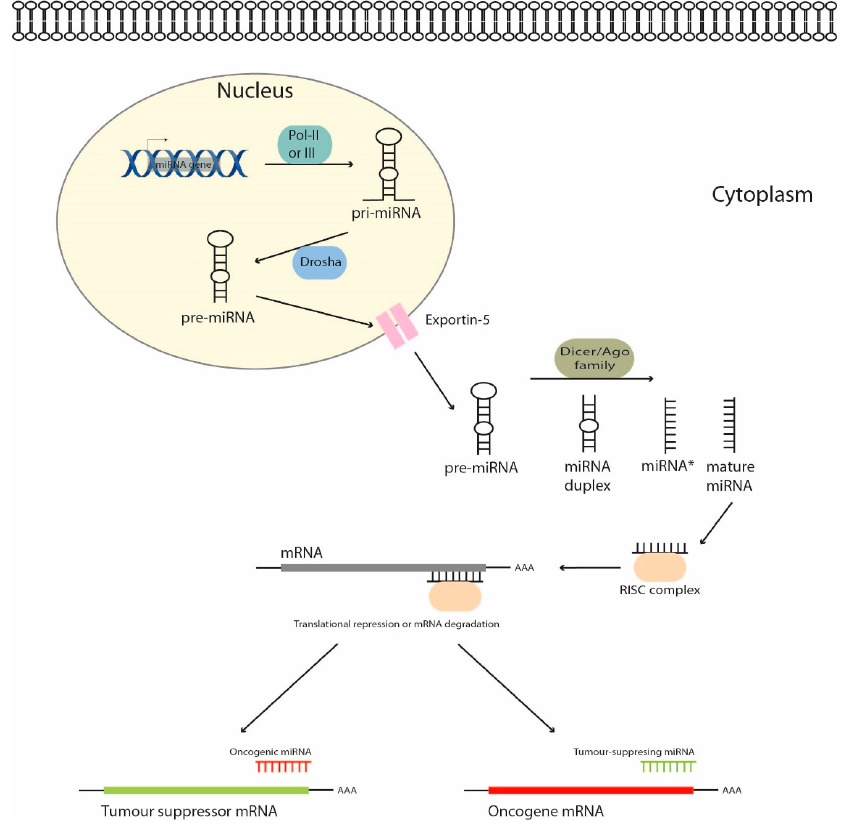
Figure 1. MicroRNA biogenesis in mammalian cells. MiRNA genes are transcribed by